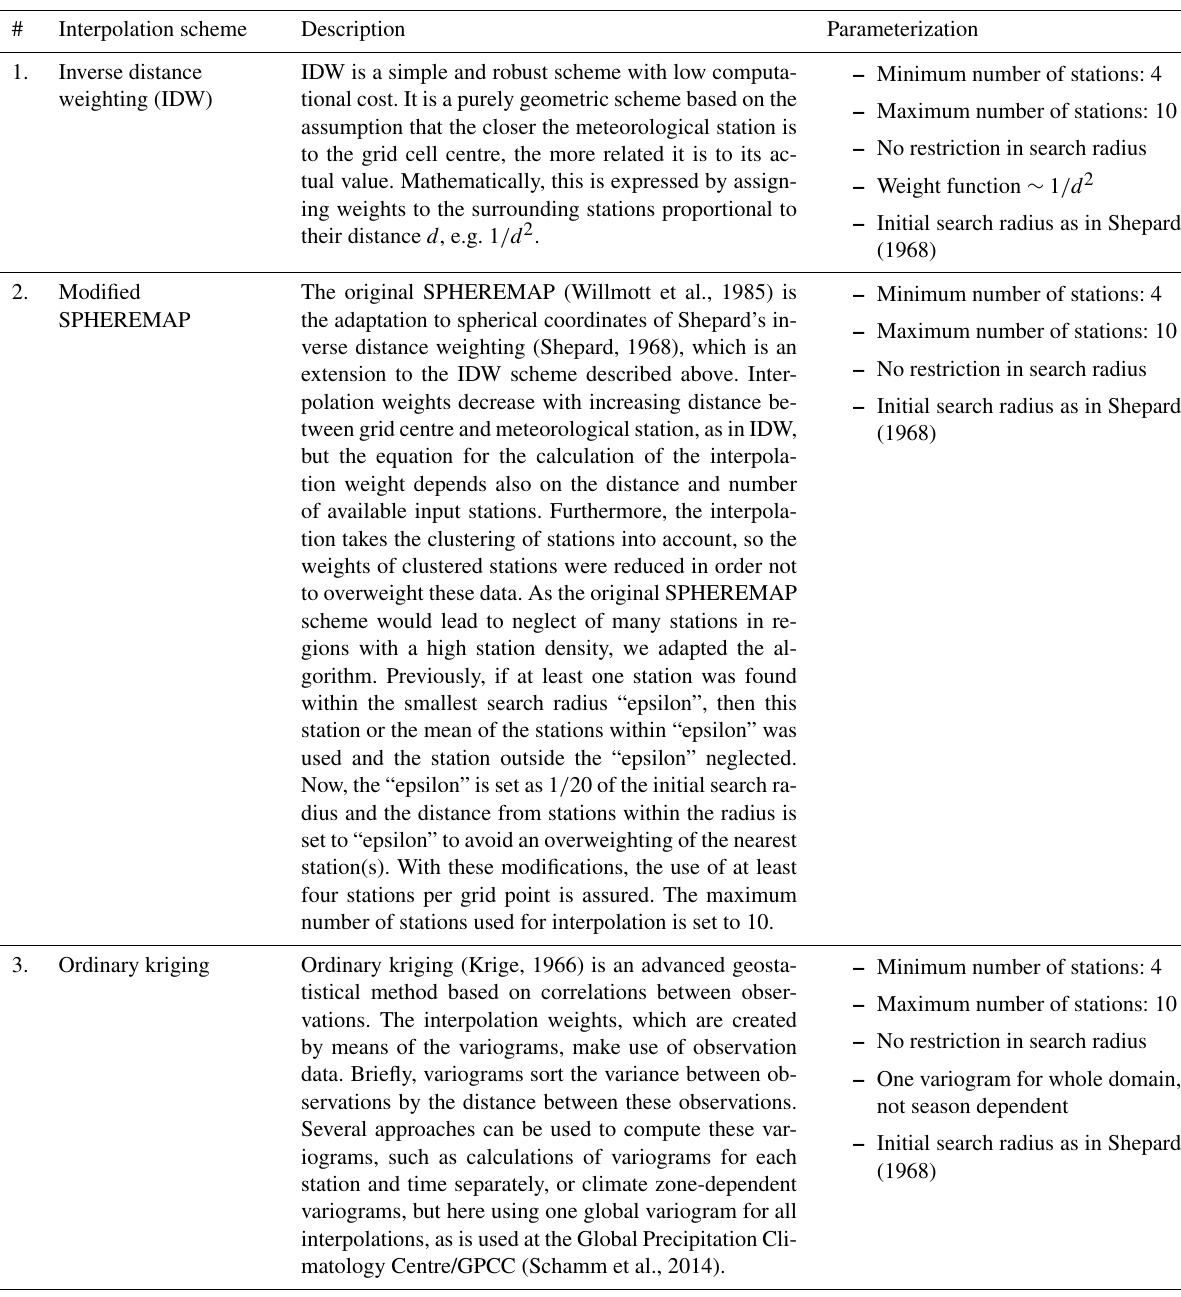
Table 4. Overview of the three spatial interpolation schemes that were evaluated for the purposes of EMO-5. # Interpolation